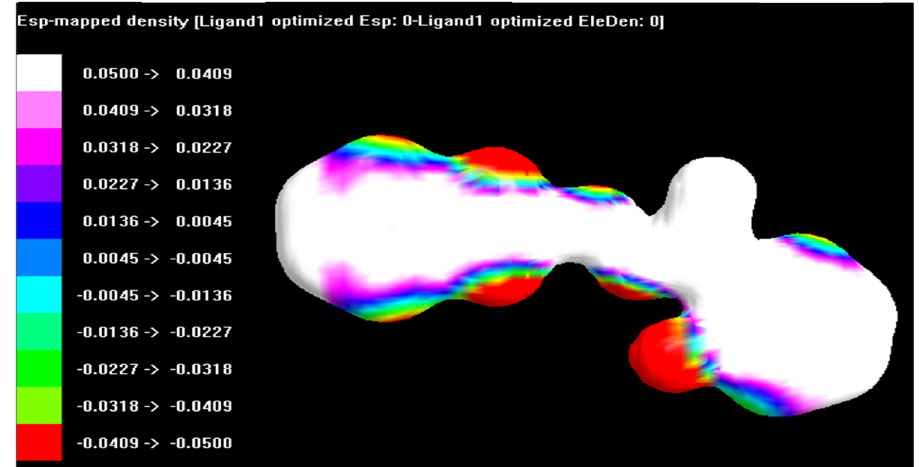
Figure 6: The ESP surface of the Schi ff base ligand, L 1